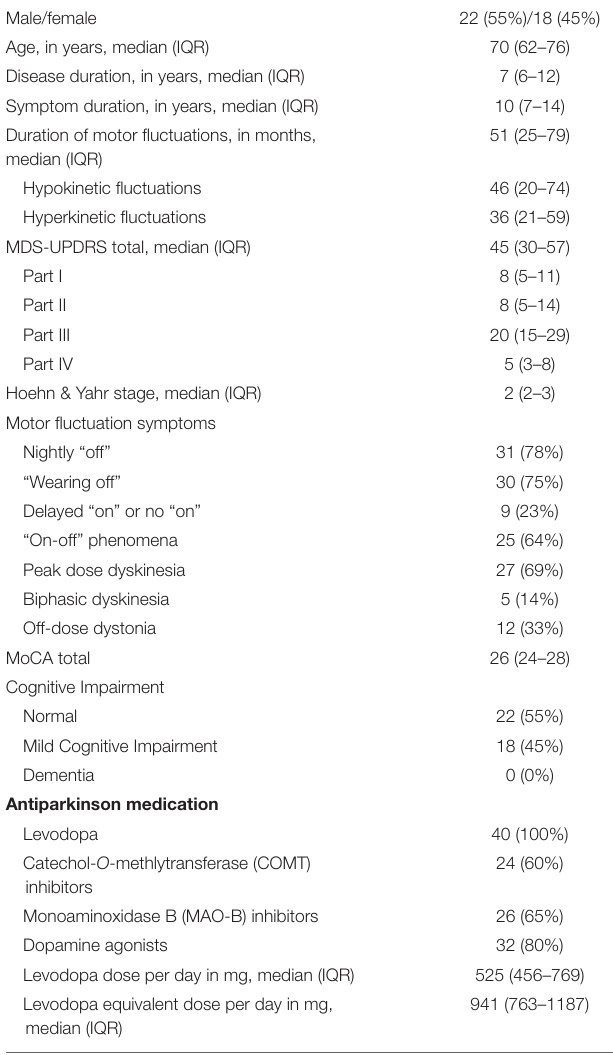
TABLE 1 | Demographic data, disease characteristics, and clinical instruments ( n =